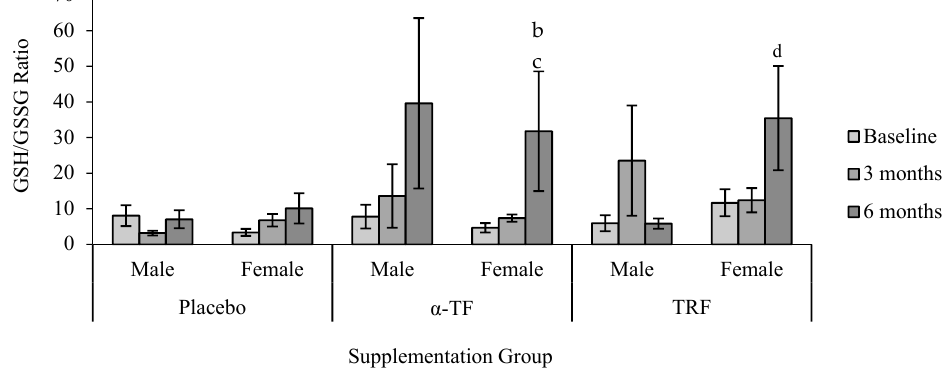
Figure 12. Effect of α -TF and TRF supplementation between male and female on GSH/GSSG ratio for